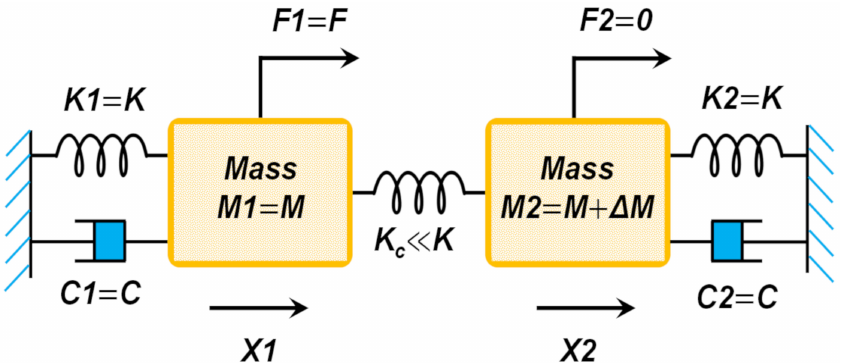
Figure 6. Mass spring damper representation of the coupled MEMS resonator system when a mass perturbation ( ∆ M ) is introduced in one of the coupled